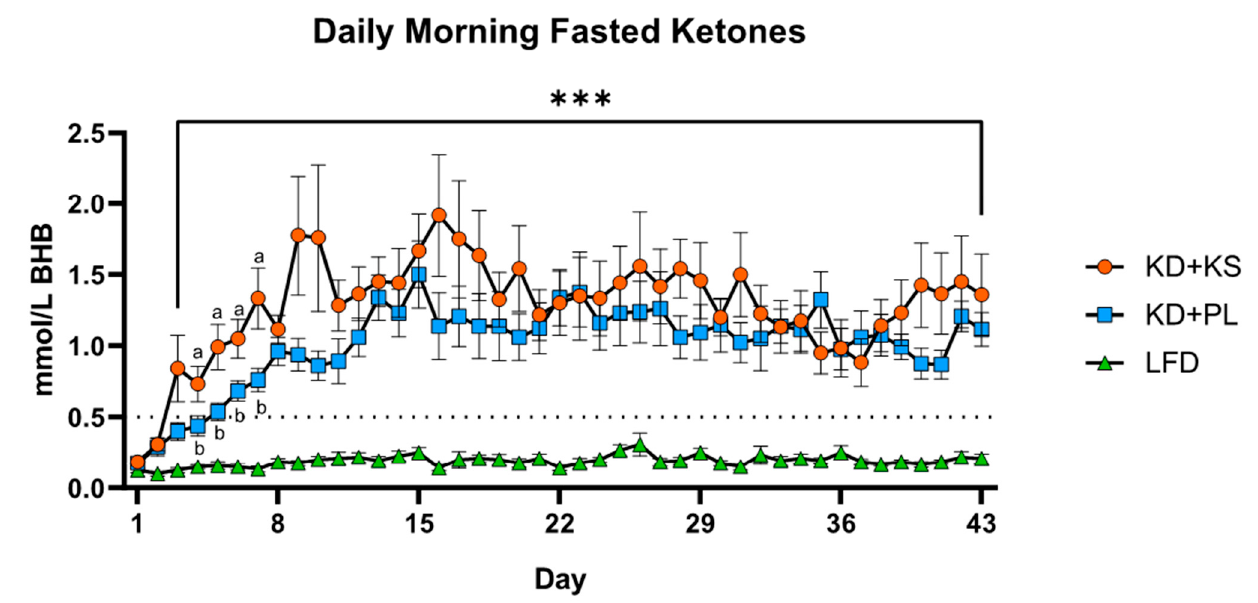
Figure 2. Daily measurements of fasted β HB recorded before breakfast and at least 10 h after supplement ingestion. All values reported as mean ± SEM. KD + KS and KD + PL ketones increased significantly from baseline (***) ( p < 0.001) and were significantly higher than LFD ( p < 0.001). Distinct letters denote significant differences between KD + KS and KD + PL. Table 4. Serum biomarkers and anthropometry changes—NAFLD subgroup (KD n = 7; LFD n = 5).